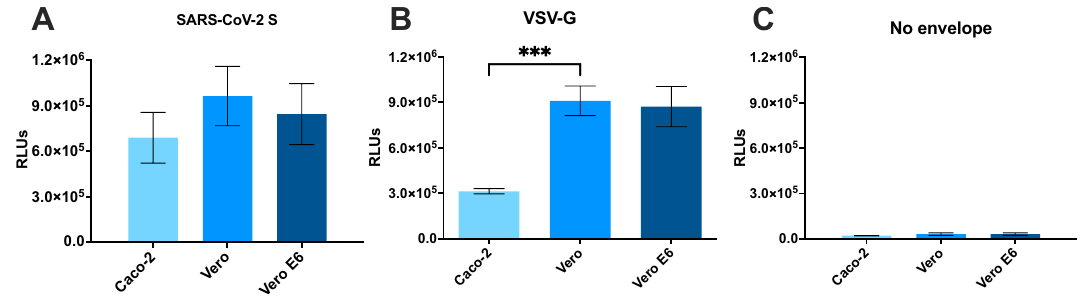
Figure 4. Transduction levels in Caco-2, Vero, and Vero E6 cells 24 h post-inoculation with VP, as evidenced by luminescence in relative light units (RLUs) caused by Nluc digestion of a furimazine substrate. The 3 cell lines were infected with 140 pg VP pseudotyped using ( A ) SARS-CoV-2 S, ( B ) VSV-G, or ( C ) no envelope glycoprotein. Results represent the average of 3 separate experiments performed in duplicate, and standard deviations of these results are shown, p < 0.001